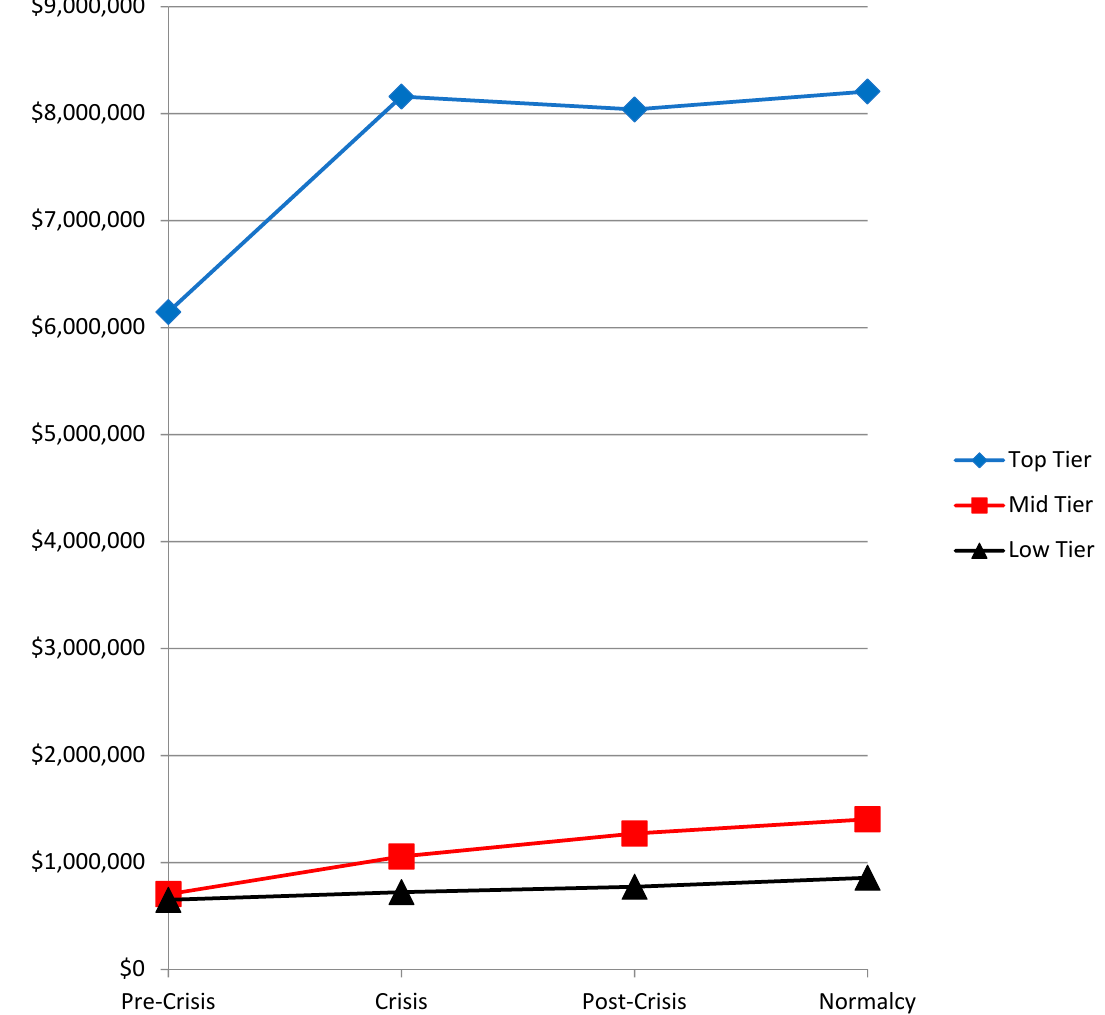
Figure 1. Average Total Assets in millions of 2015 Dollars. Notes: Top-Tier: JPMorgan Chase, Bank of America, Citigroup, and Wells Fargo; Mid-tier: Bank of New York Mellon, State Street, US Bancorp, and PNC Financial Services Group; Low-tier: Capital One Financial, BB&T, SunTrust Banks, and Regions Financial. Pre-crisis: 2005–2007; Crisis: 2008–2010; Post-Crisis: 2011–2013; Normalcy: 2014–2016. Data obtained from published financial reports.